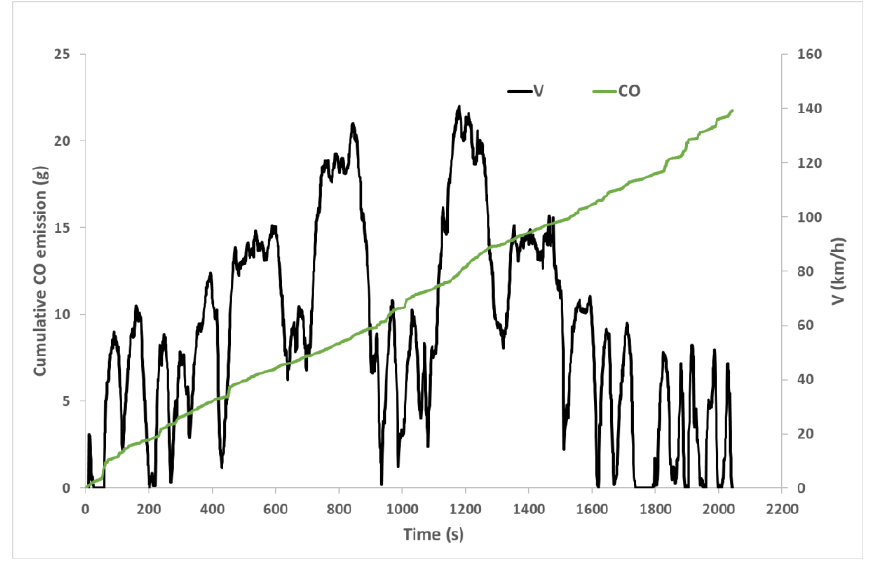
Figure 18. Cumulative CO emission versus vehicle speed in on-road test, CNG propulsion.